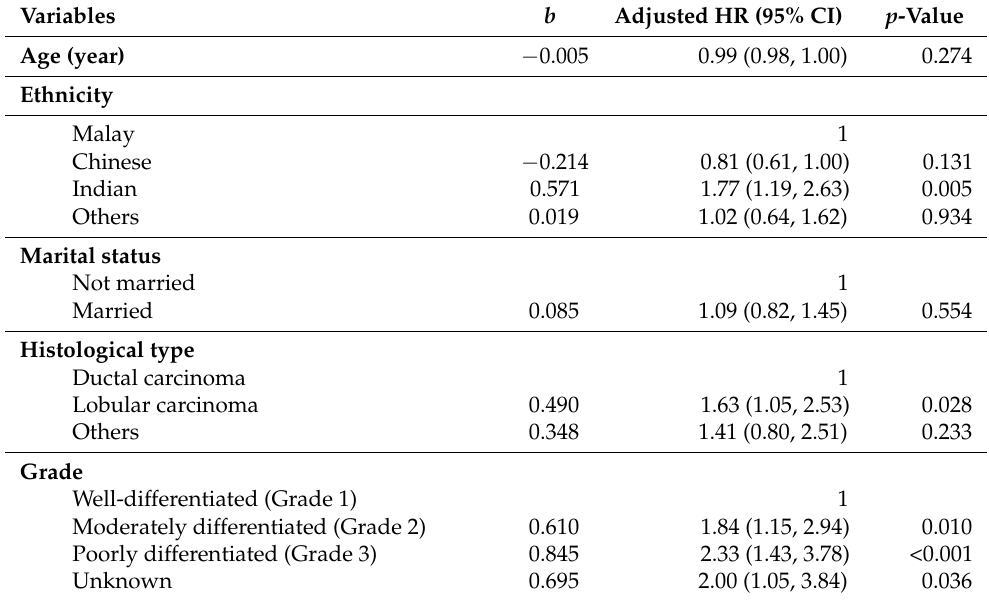
Table 3. Multivariable Cox proportional hazards regression model to predict death among women with breast cancer ( n =